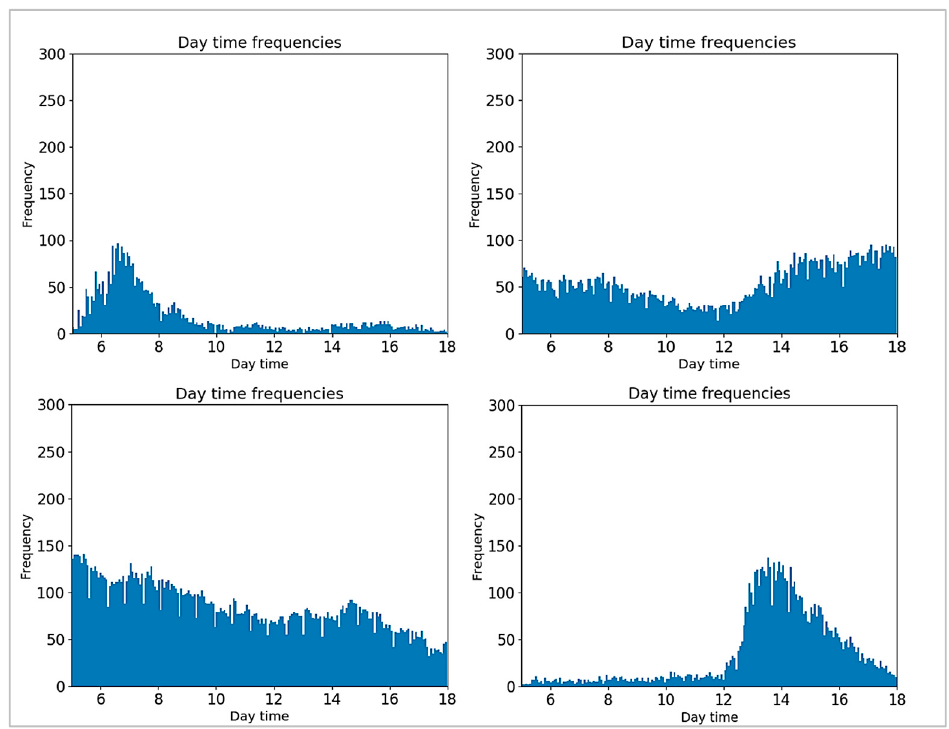
ff erent users during the morning